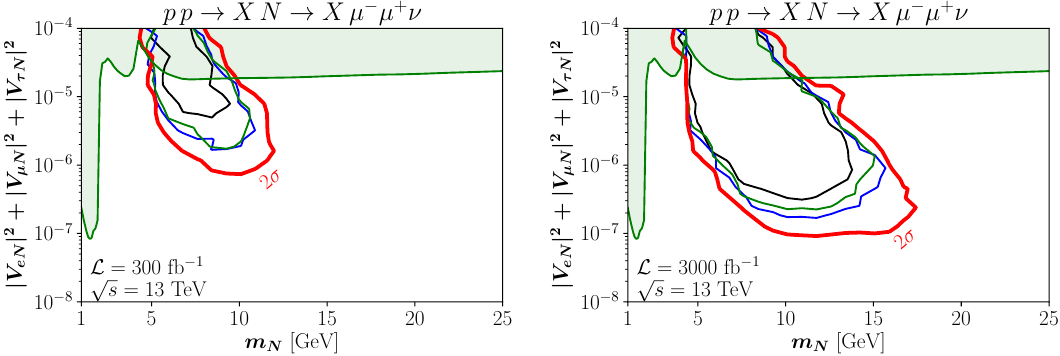
Figure 7 . Inclusive HNL production followed by its decay into di(cid:11)erent channels, for mixings 2 : 2 : 2 =1:0:0 (black), 1:1:0 (blue), 1:1:1 (green) and 0:1:0 (thick red). The solid V eN V (cid:22)N V (cid:28)N j j j j j j lines are contour lines for 2 (cid:27) exclusion with DV at the LHC 13 TeV with = 3000 fb (cid:0) 1 (right) and the cuts described in section 4.4. Shaded green areas are excluded by L experimental bounds. These sensitivity lines are obtained under the background-free hypothesis, see the discussion in the